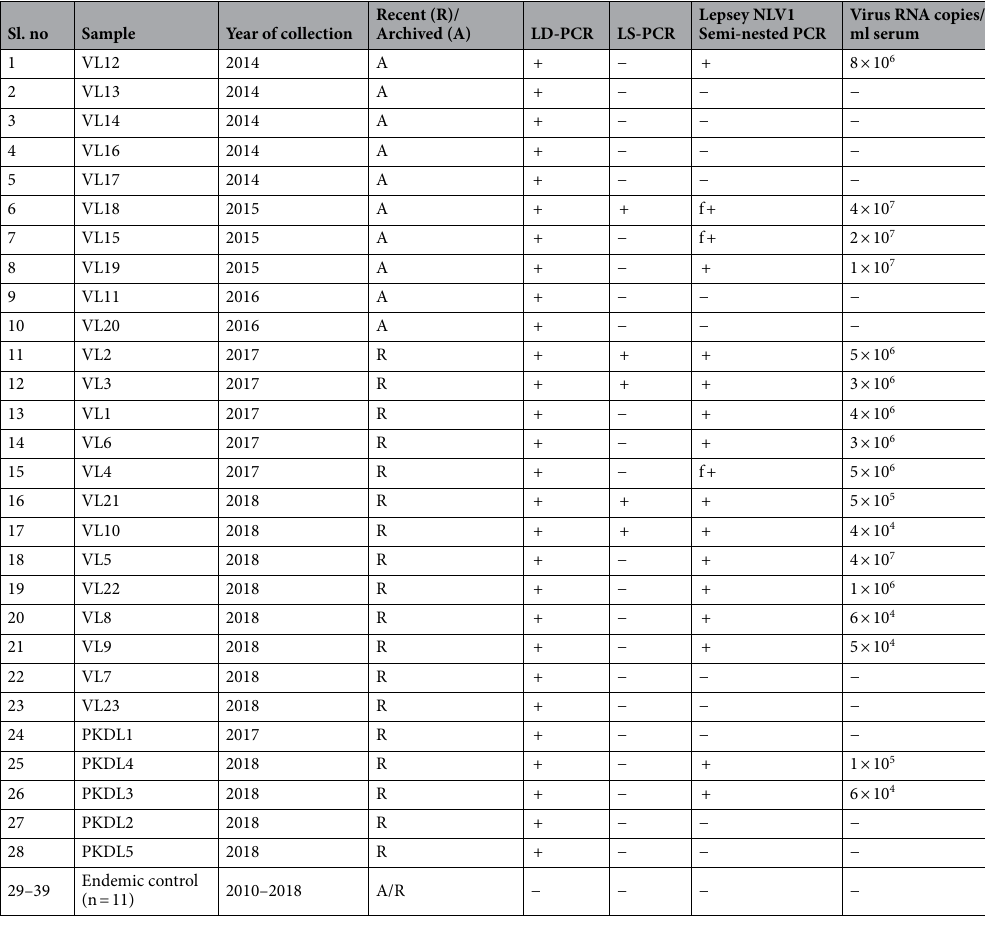
Table 1. Screening of recent and archived Kala-azar/PKDL serum samples from India for Lepsey